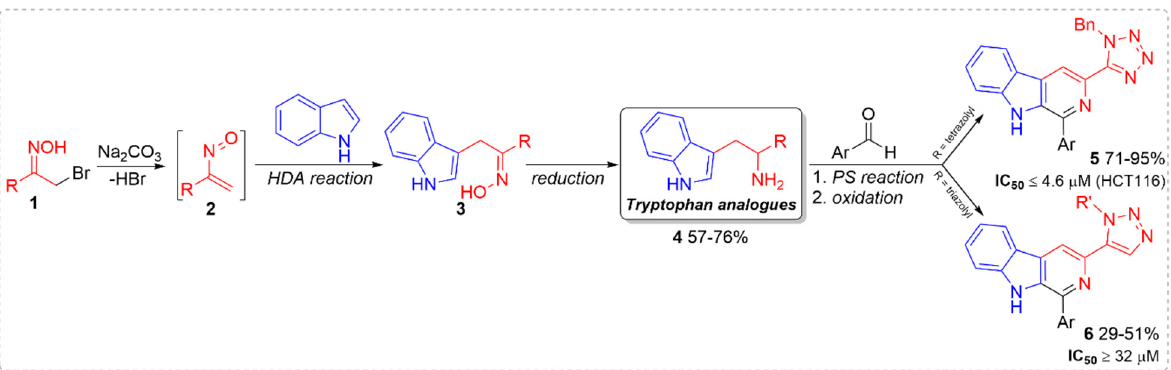
Figure 1. Synthetic route of β -carboline derivatives tested in human colon cancer cell Figure 36. Synthetic route of β-carboline derivatives tested in human colon cancer cell lines.